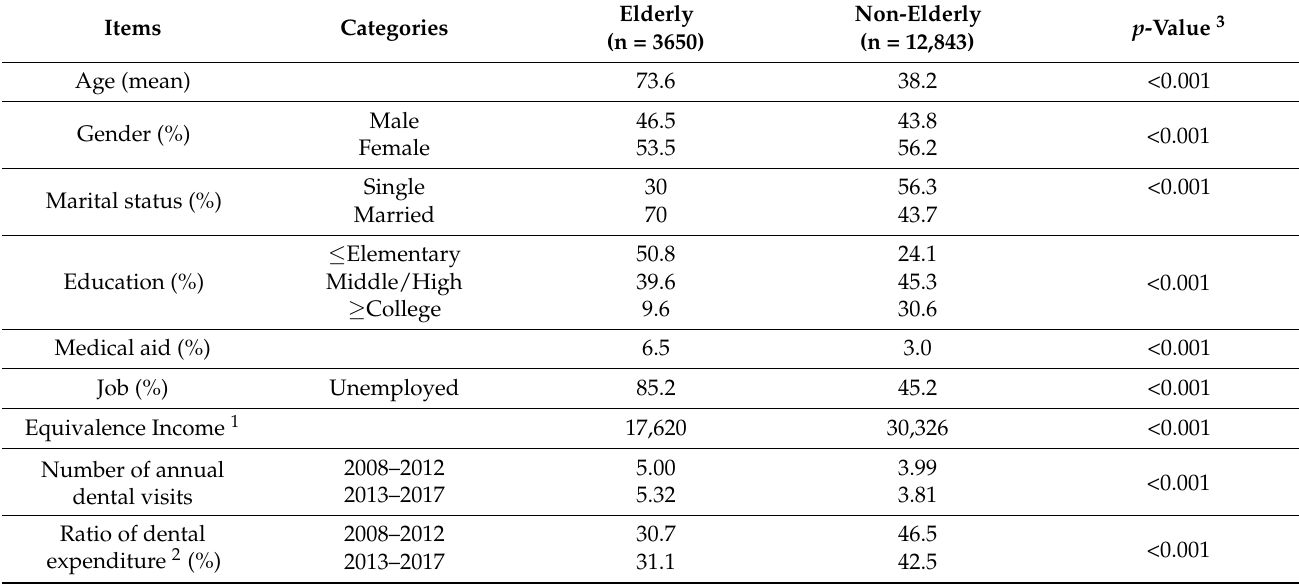
Table 2. Sample characteristics.